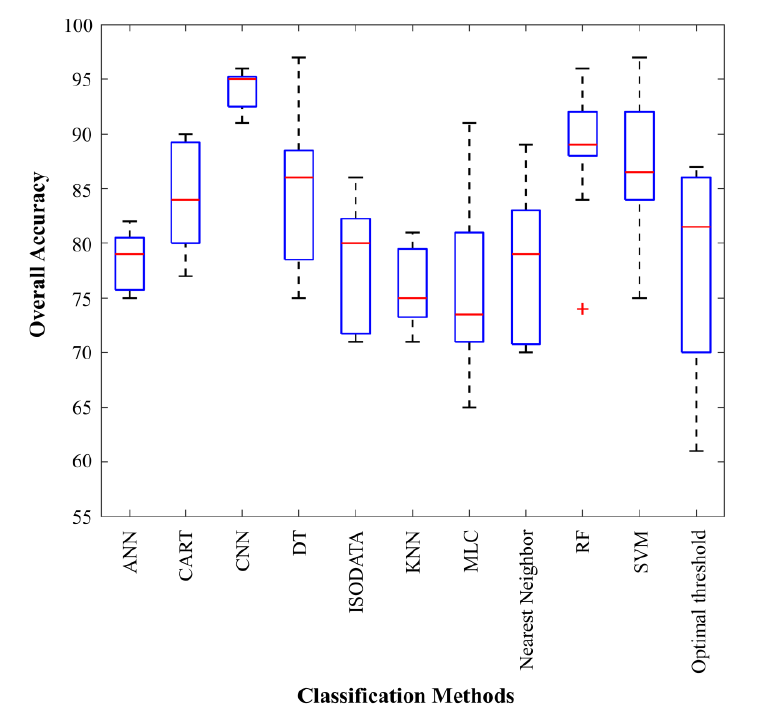
Figure 19. Overall accuracy of various classification methods.